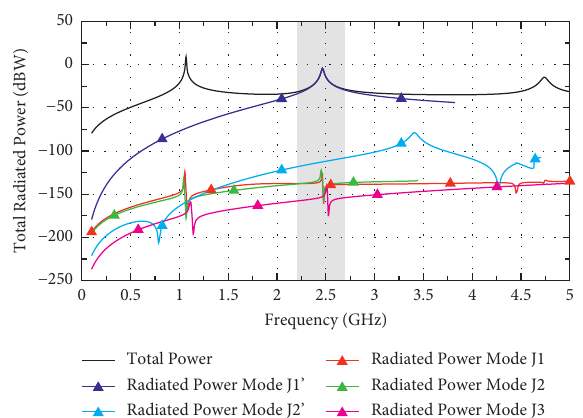
Figure 6: Total power and modal radiated power for two parallel plates with the same size.